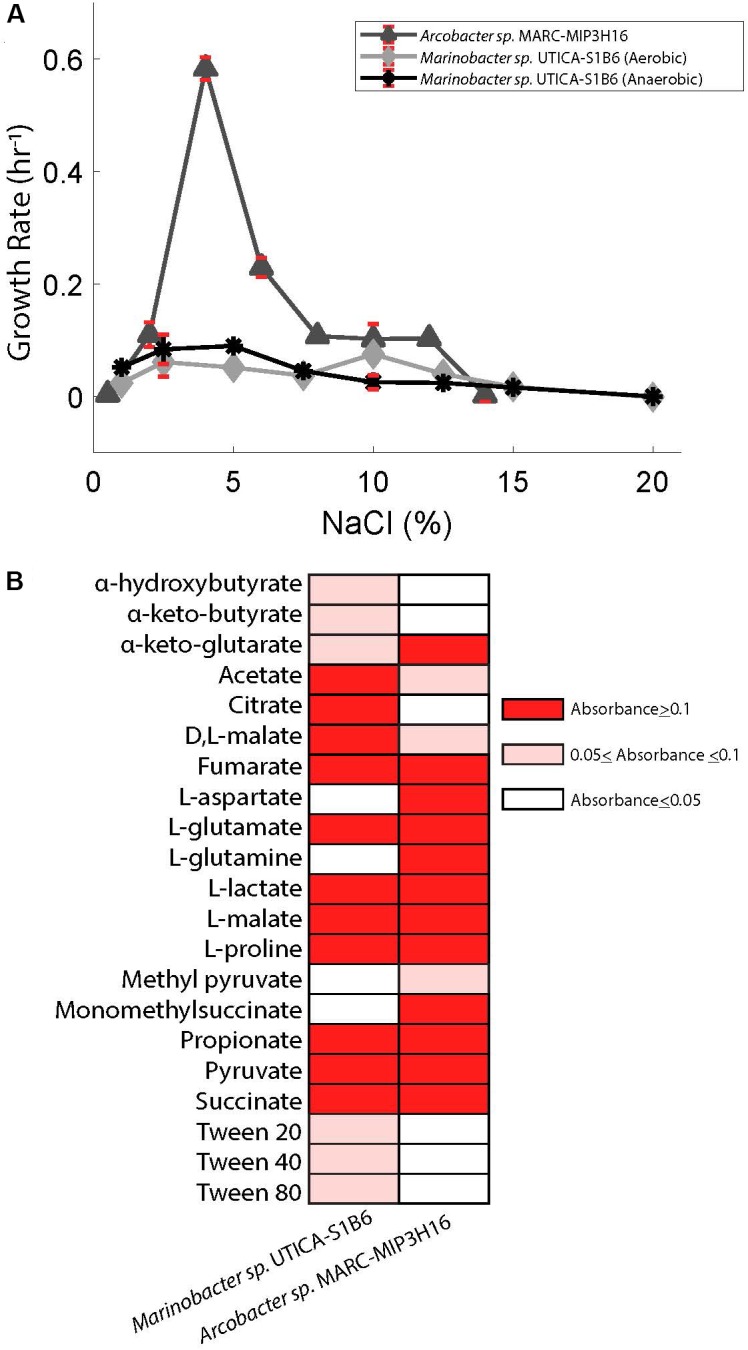
(A) Superimposed salinity growth rate curves for Arcobacter sp. MARC-MIP3H16 and Marinobacter sp. UTICA-S1B6. Error bars denote standard deviation from triplicate measurements. (B) Carbon sources utilized by Marinobacter sp. UTICA-S1B6 and Arcobacter sp. MARC-MIP3H16. Negative controls registered absorbance values of 0.023 and 0.014, respectively. Any absorbance readings under 0.05 were considered negative and assigned a white color in this figure.